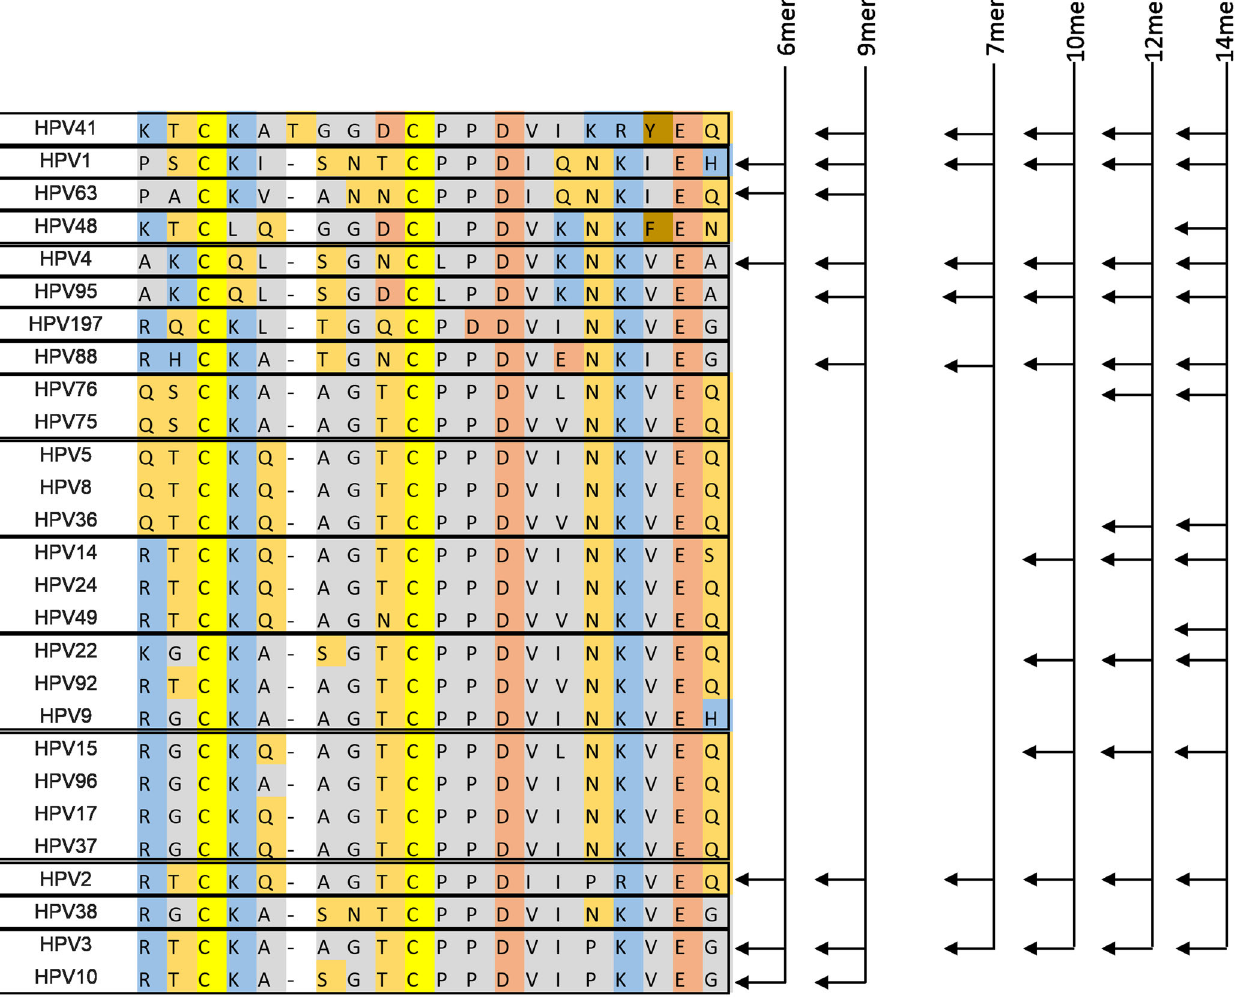
Fig. 4 Multiple alignment of 27 cutaneous HPV L2 aa 20-38 epitopes. At the left side of the scheme, the amino acid sequence similarities are shown by different colors, and epitopes with a similatiry >95% are grouped by boxes. On the right, the presence of each corresponding L2 aa 20 – 38 epitope in each of the designed polytopic antigens is highlighted by